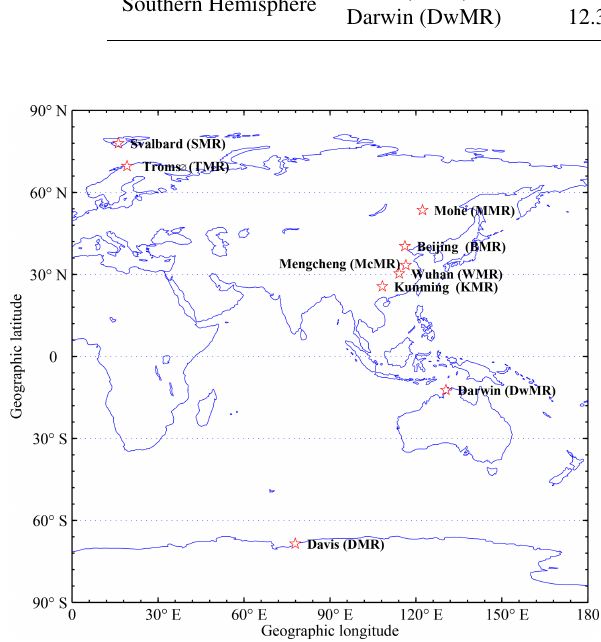
Figure 1. The locations of the meteor radars used in this study.